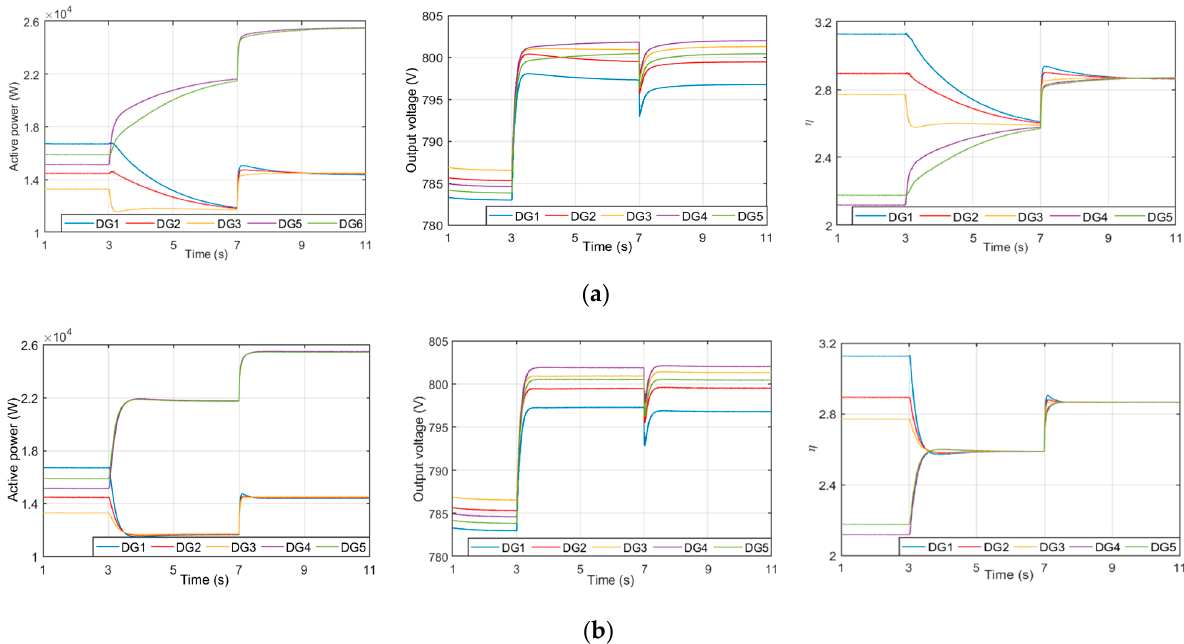
Figure 6. Simulation results of active powers, output voltages and incremental costs in synchronous communication case. ( a ) Consensus algorithm. ( b ) Fast convergence algorithm.